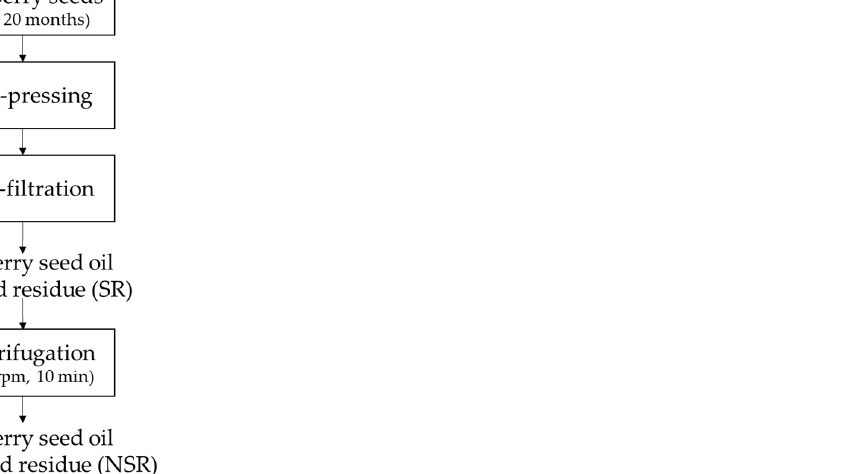
Figure 1. Flowchart to obtain raspberry seed oil (SR) and clarified without seed residue (NSR).